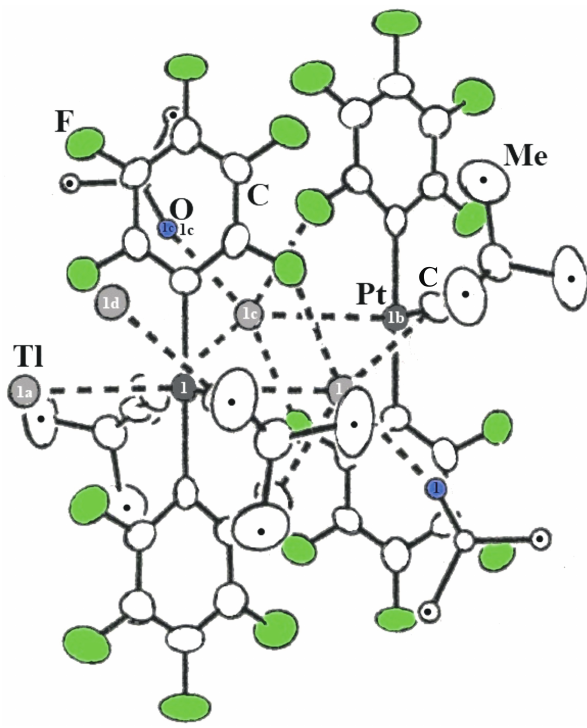
(C F ) (C ≡ CBu t ) 2 6 5 2